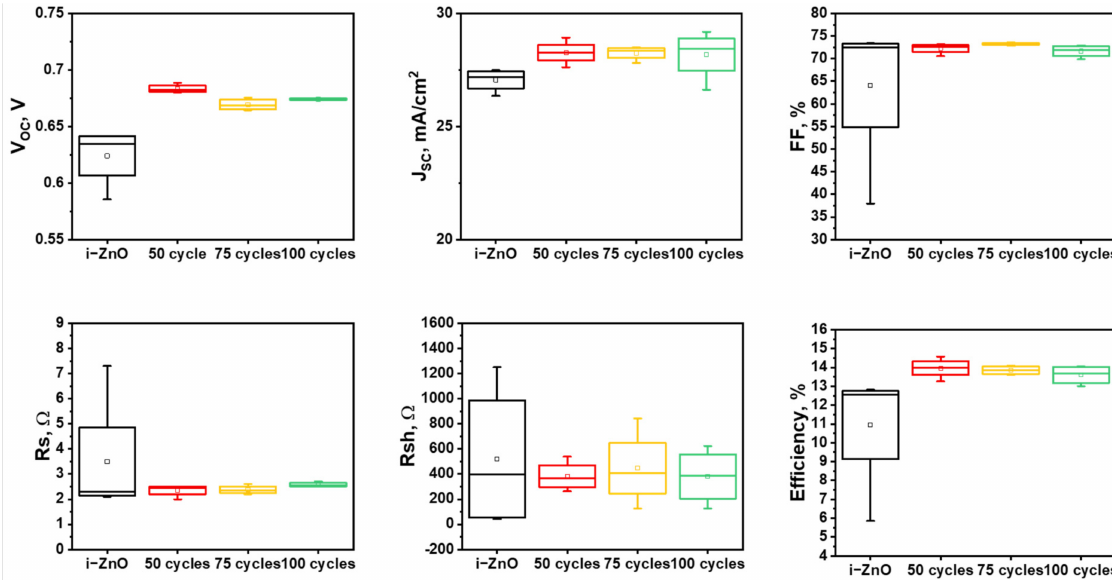
Figure 5. Photovoltaic parameters of CIGS solar cells with i-ZnO and A-ZnO window layers of different